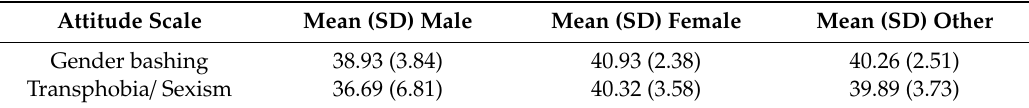
Table 2. Means and standard deviations for the three gender categories.